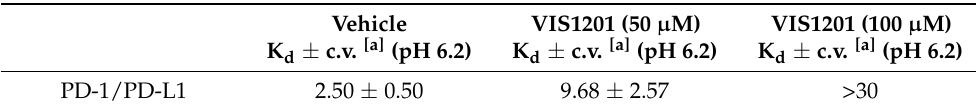
Table 4. Dissociation constants (K d ) of PD-1/PD-L1 in presence of increasing concentrations of VIS1201 ( 17 ) at pH 6.2.